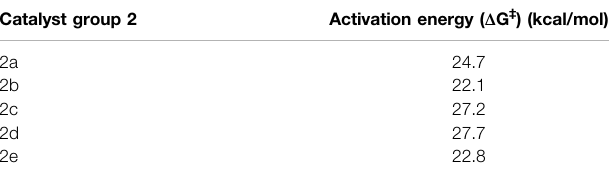
TABLE 2 | Catalytic performance of Group 2 catalyst, 2a – 2e . Catalyst group 2